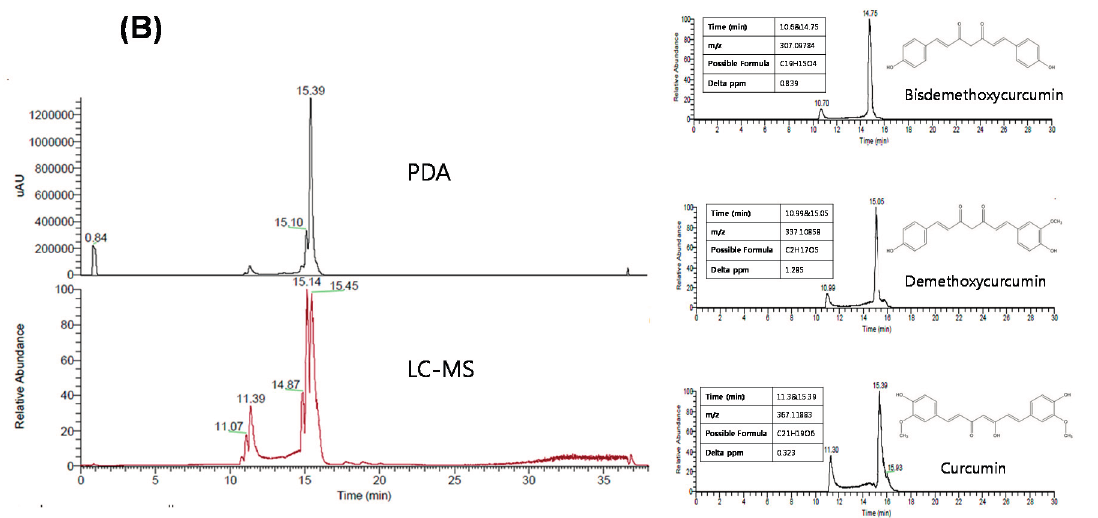
Figure 3. Simultaneous HPLC-PDA and HPLC-MS chromatograms of the guava leaf extract ( A ) and turmeric extract ( B